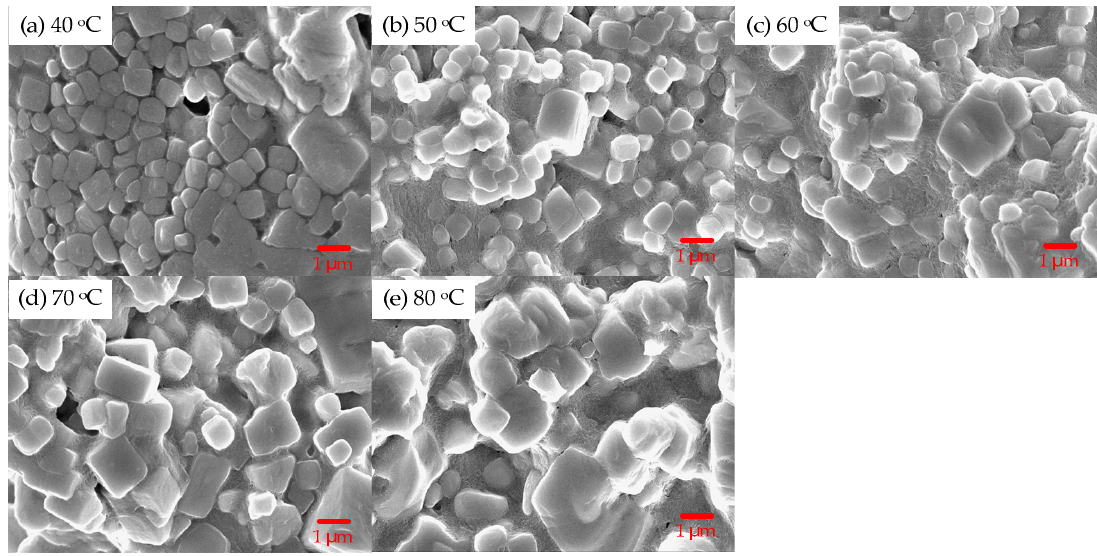
Figure 3. Scanning electron microscopy (SEM) images of the MAPbBr 3 crystals growth temperature ◦ C, ( b ) 50 ◦ C, ( c ) 60 ◦ C, ( d ) 70 ◦ C, and ( e ) 80 ◦ at ( a ) 40 °C, ( b ) 50 °C, ( c ) 60 °C, ( d ) 70 °C, and ( e ) 80 °C. ( a ) 40